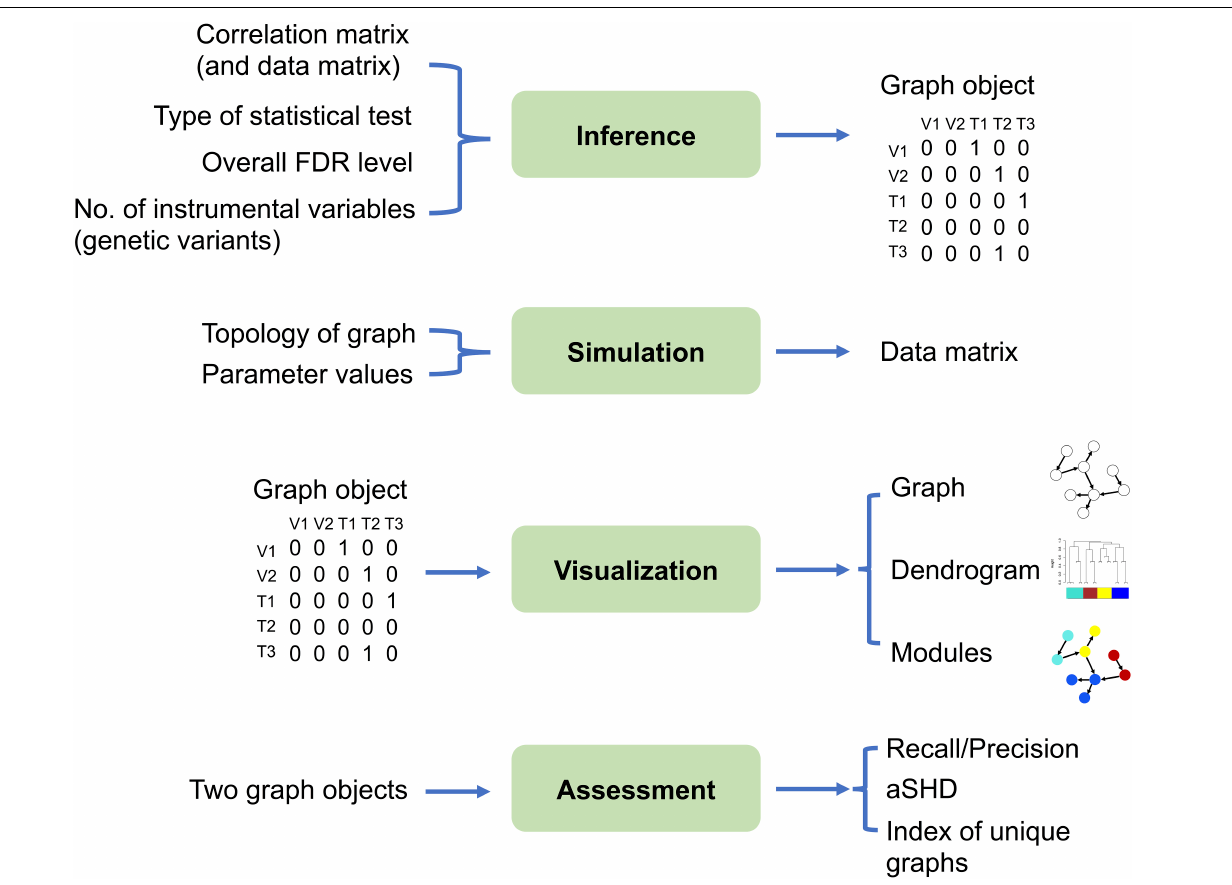
FIGURE 2 | The four modules in the MRPC package. Inputs are listed on the left and outputs on the right. The inference module is at the center of the package, which may take the correlation matrix from real or simulated data as input, and outputs a graph object, the core of which is the (asymmetric) adjacency matrix. For genomic data, we require that the genotype (instrumental variable) nodes are placed in the data matrix before the phenotype nodes. Thus, the rows and columns of the correlation matrix and the adjacency matrix also start with genotypes, followed by phenotypes. The simulation module can generate a data matrix from which the correlation matrix may be derived and used as input to the inference module. A graph object, constructed directly or provided by the inference module, can be passed through the visualization module for displaying the graph topology and for clustering nodes into modules. The difference between two graph objects (e.g., true and inferred graphs, graphs inferred by two different methods) may be evaluated by multiple metrics in the assessment module.